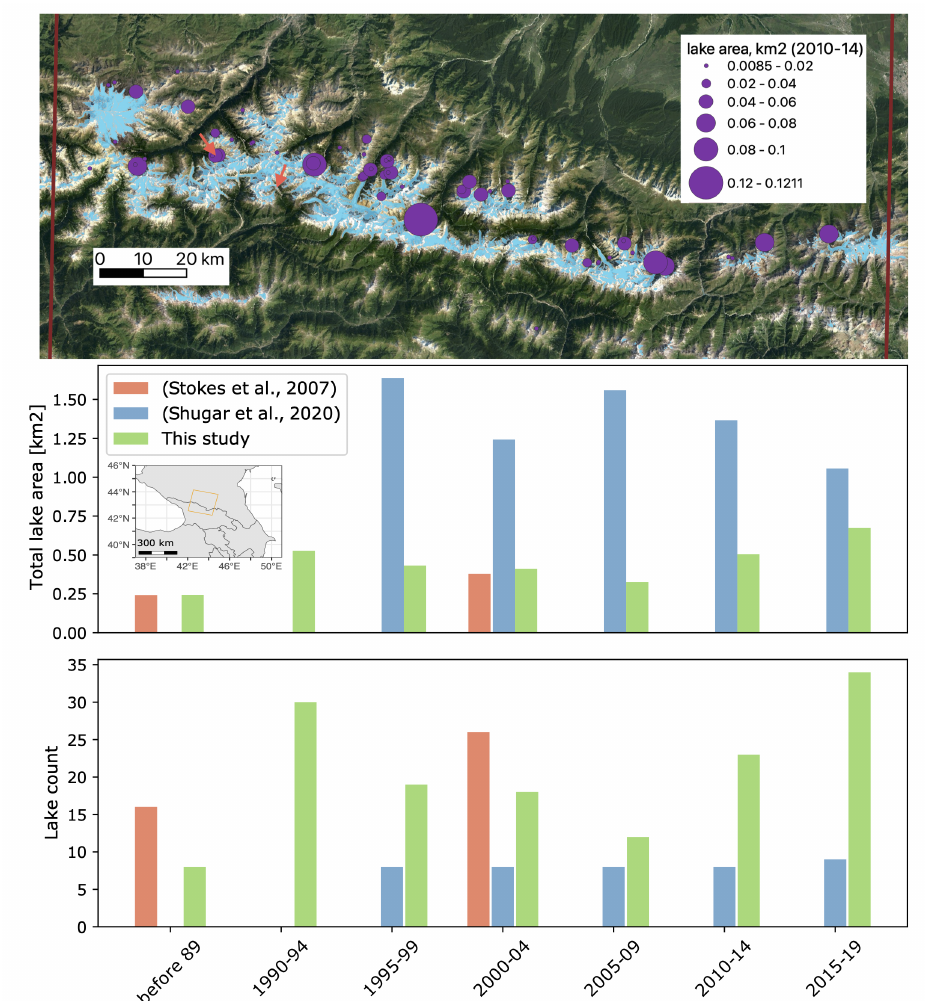
Figure 4. Spatial and temporal distribution of the glacial lakes. The results are shown for the footprint of the Landsat frame (path: 171, row: 30). Upper panel: distribution of glacial lakes of the different sizes (2010–2014 epoch). The red line shows the Landsat frame footprint, the blue polygons correspond to the glacier outlines [51] (Background image: Google Earth). Lower panel: comparison of the classification results and existing glacial lake inventories by [6,16]. Red arrows indicate the location of the examples, shown on the Figure 3. The western red arrow indicates the location of Bashkara lake, the eastern one the unnamed landslide